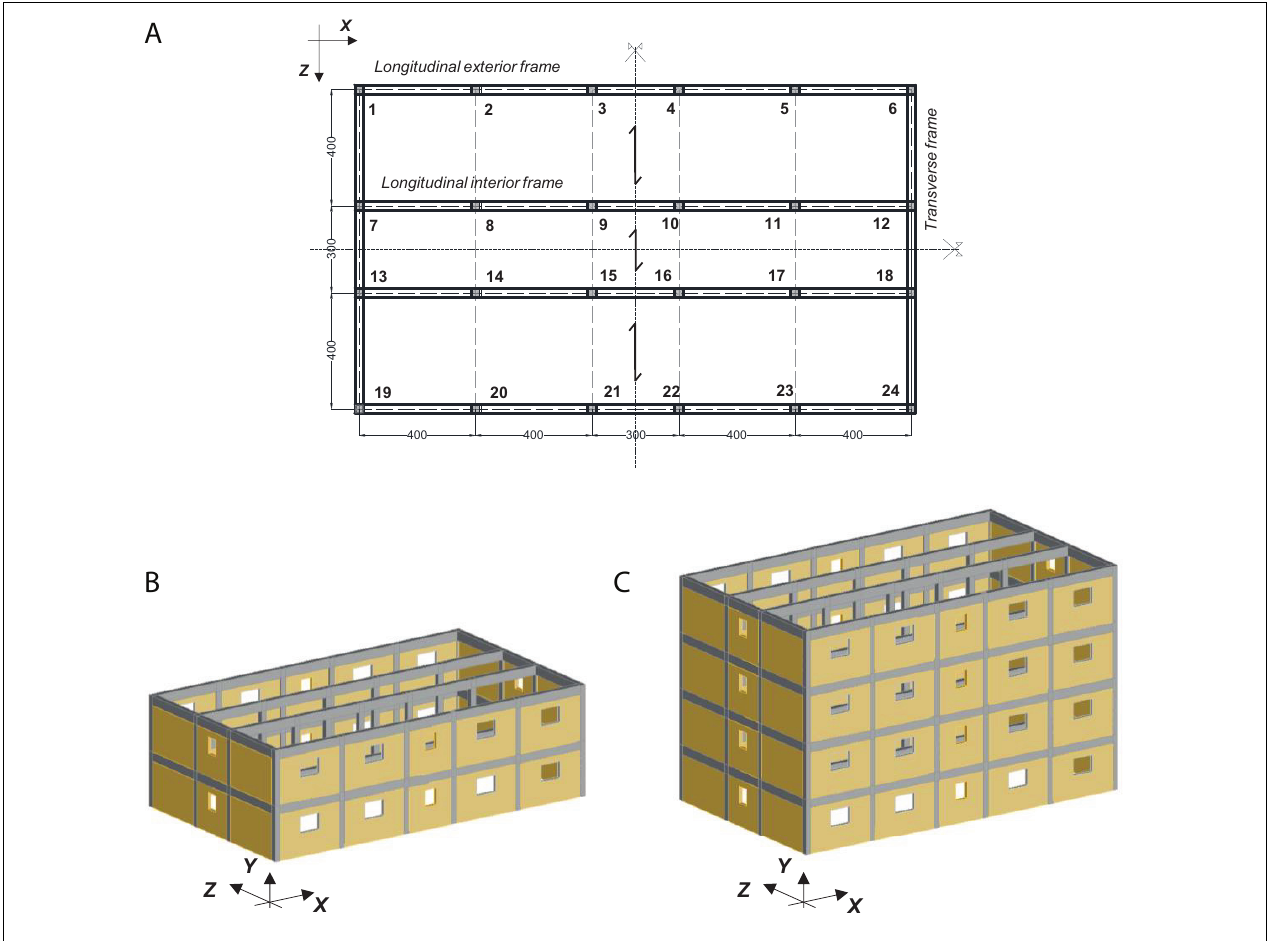
FIGURE 3 | Plan disposal of the case study buildings and column labels (A) , 3D view of two-story (B) , and four-story (C) buildings (measures are in centimeters). TABLE 5 | Geometric percentage of longitudinal reinforcement in first-floor columns (cross-section dimensions in brackets). Column